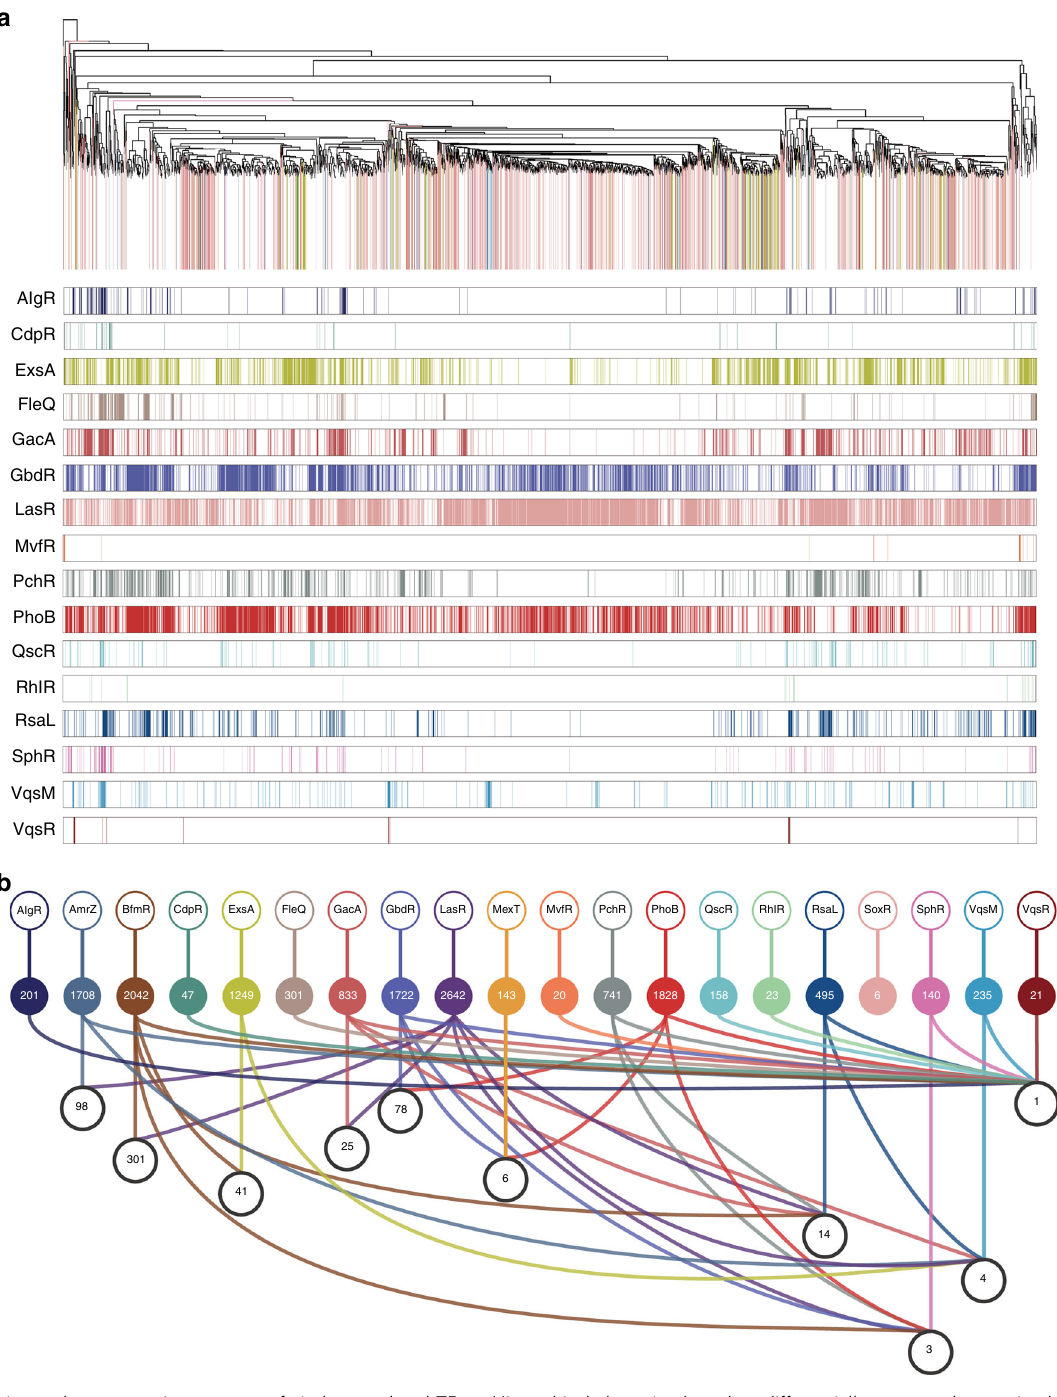
Fig. 3 Clustering and co-expression patterns of virulence-related TFs. a Hierarchical clustering based on differentially expressed genes in absence of TFs using Pearson correlation coef fi cients. 4775 genes were differentially regulated by 16 transcription factors obtained from our RNA-seq. Genes regulated by more than one TFs are coloured in white. b Co-expression patterns of differentially regulated genes dependent upon 20 TFs, white balls lined between different TFs balls represent the number of genes that are co-regulated by the TFs